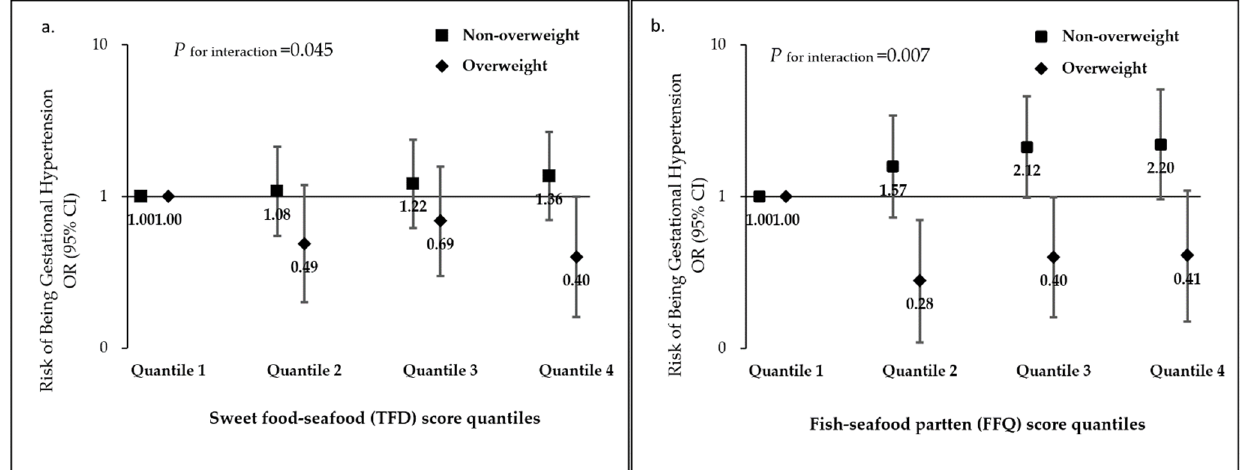
Figure 1. Associations of maternal ( a ) Sweet food-seafood (TFD), ( b ) Fish–seafood pattern (FFQ) scores during pregnancy, in quartiles, with risk of gestational hypertension, stratified by pre-pregnancy weight (overweight vs. non-overweight). OR: odds ratio, CI: confidence interval, TFD: three-day food dairies, FFQ: food frequency questionnaire, OwOb: overweight/obese.